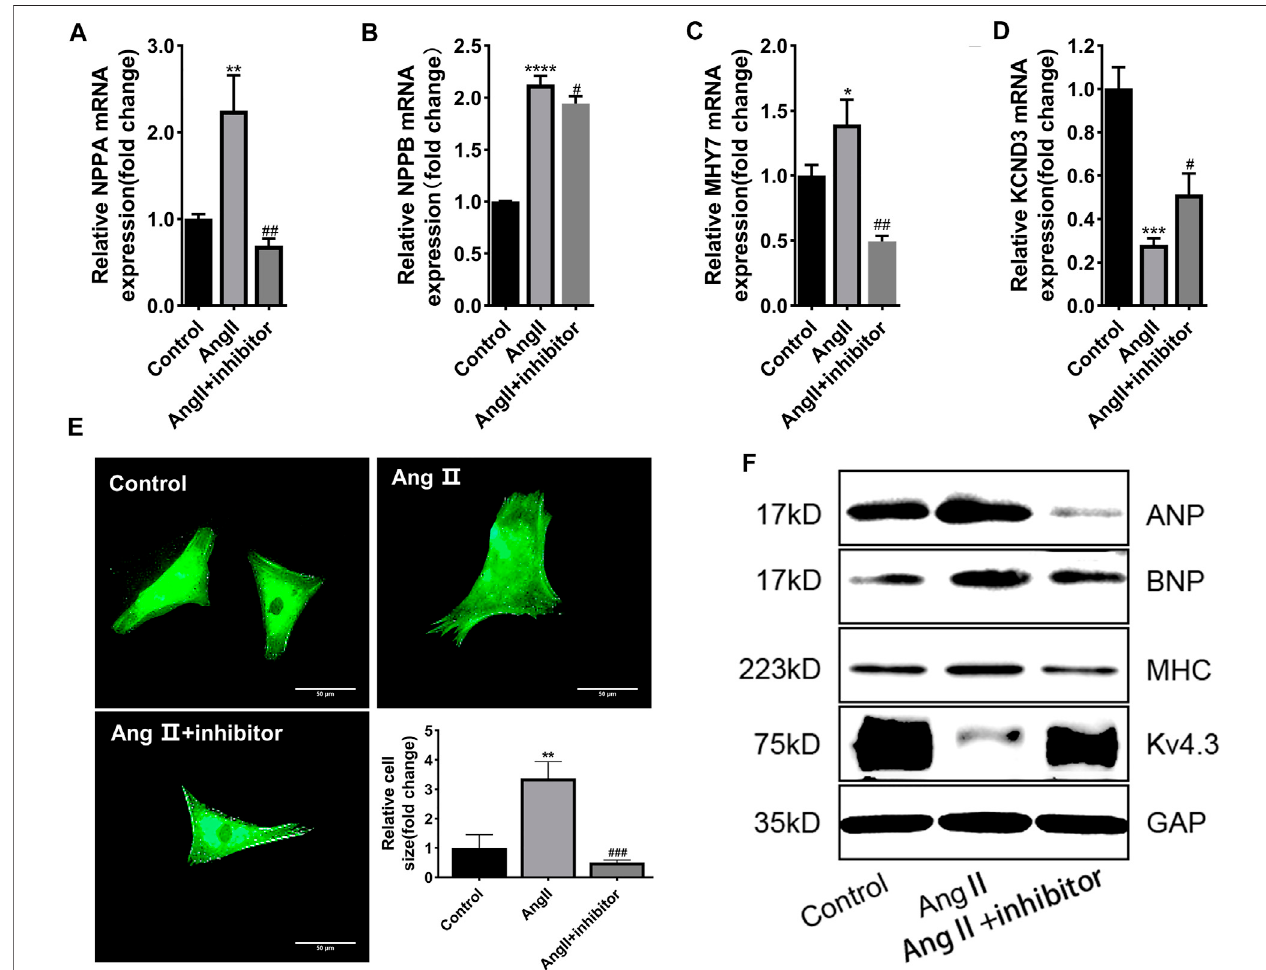
FIGURE 2 | MiR-27a-3p is involved in the process of myocardial hypertrophy induced by Ang II. (A – C) The expressions of cardiac hypertrophy related genes NPPA, NPPB, and MHY7 were decreased after Ang II + miR-27a-3p inhibitor treatment compared with the Ang II treatment. (D) The expression of KCND3 decreased after Ang II treatment, while increased in Ang II + miR-27a-3p inhibitor treatment. (E) Morphological changes after Ang II and miR-27a-3p inhibitor treatment in neonatal rat cardiomyocytes. Scale bar, 50 μ m. (F) The protein expressions of cardiac hypertrophy related genes ANP, BNP and β -MHC were decreased, while the expression of Kv4.3 increased after Ang II + miR-27a-3p inhibitor treatment. All the values are the mean of three independent experiments ( n (cid:2) 3). **** p < 0.0001, *** p < 0.001, ** p < 0.01, * p < 0.05 vs. control. ### p < 0.001, ## p < 0.01, # p < 0.05 vs. Ang